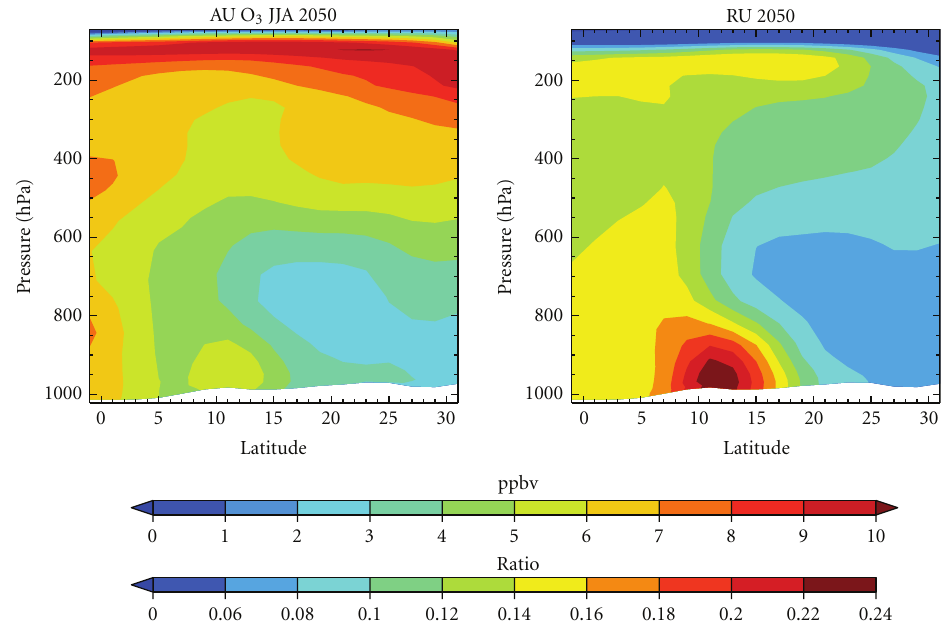
Figure 6: As for Figure 5 except for